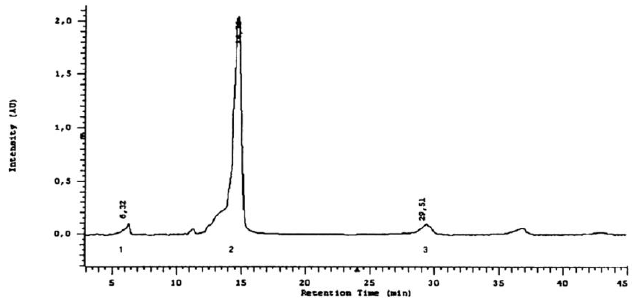
Figure 11. Separation of phenolic acids after the acid hydrolysis of methanolic extract in HPLC.